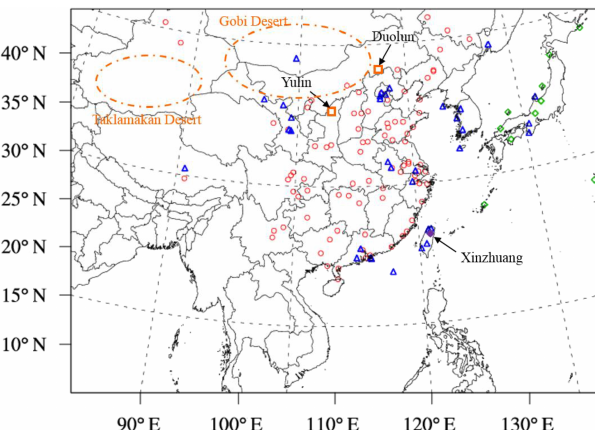
Figure 2. Modeling domain and locations of observation stations from Fudan observation network (orange rectangles), API (red circles), AERONET (AErosol RObotic NETwork; blue triangles), EANET (green diamonds), and TAQMN (purple diamonds) over East Asia.